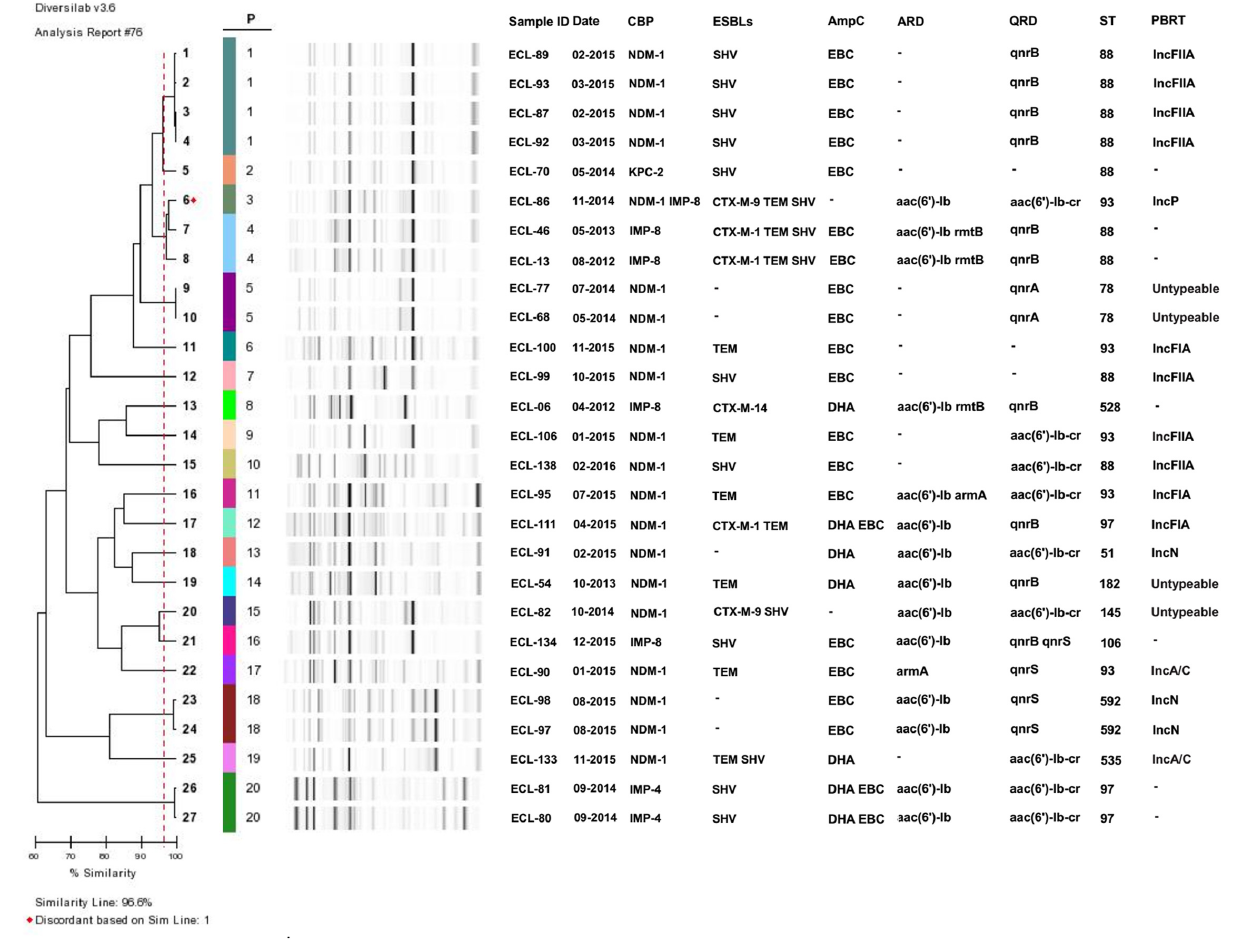
FIGURE 3 | Dendrogramanalysis of DiversiLab Rep-PCR fingerprint of carbapenemase-producing E. cloacae isolates. A genetic similarity index scale is shown in the left of the dendrogram. Isolate number, collection data, resistance determinants, MLST, and plasmid type. CBP, carbapenemase; ESBLs, extended-spectrum β -lactamase; PBRT, PCR-based replicon